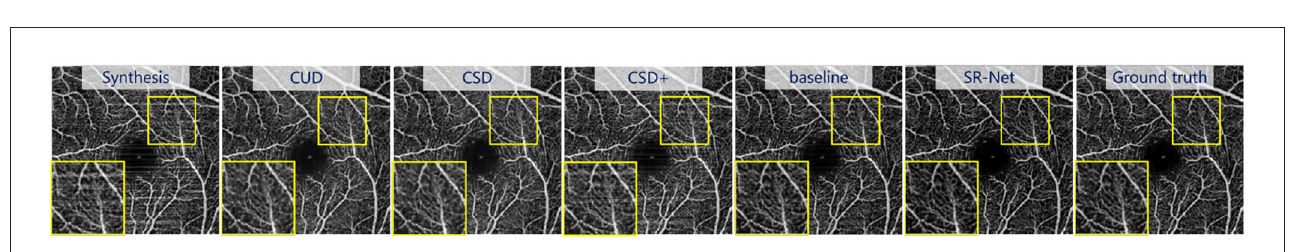
FIGURE7 Illustrative stripe removal results using different methods on a synthetic OCTA image ( i = 2) with stripe noise from the PUTH